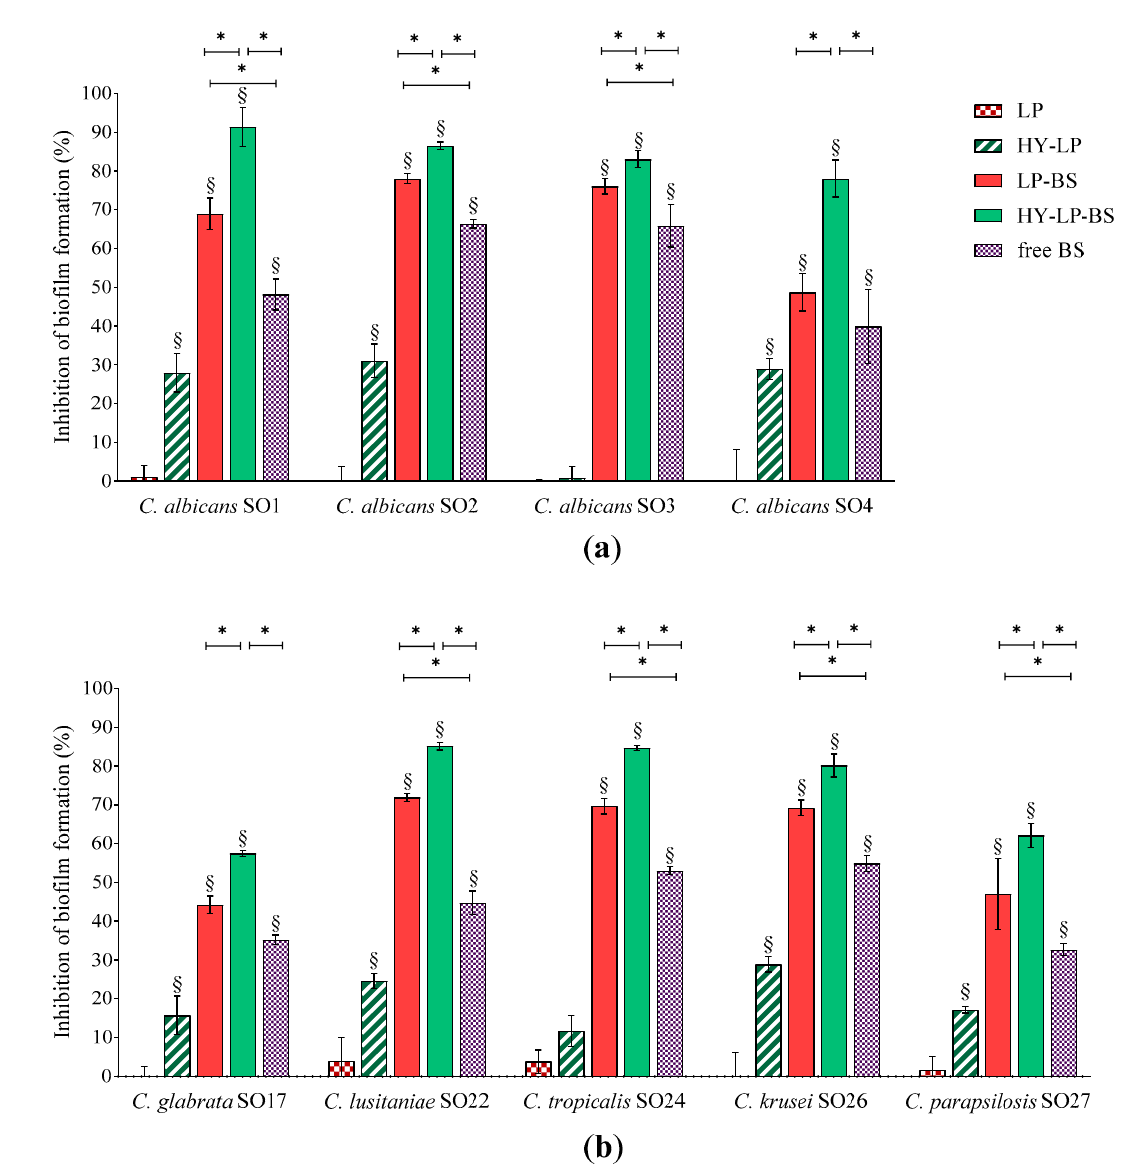
Figure 3. Anti-biofilm activity: inhibition of the development of ( a ) C. albicans and ( b ) non- albicans biofilms. Results are expressed as inhibition percentage (mean ± SD, n = 5). The statistical significance with respect to untreated control was reported, §: p < 0.01. Statistical differences between BS, LP-BS and HY-LP-BS were also calculated, *: p < 0.05.